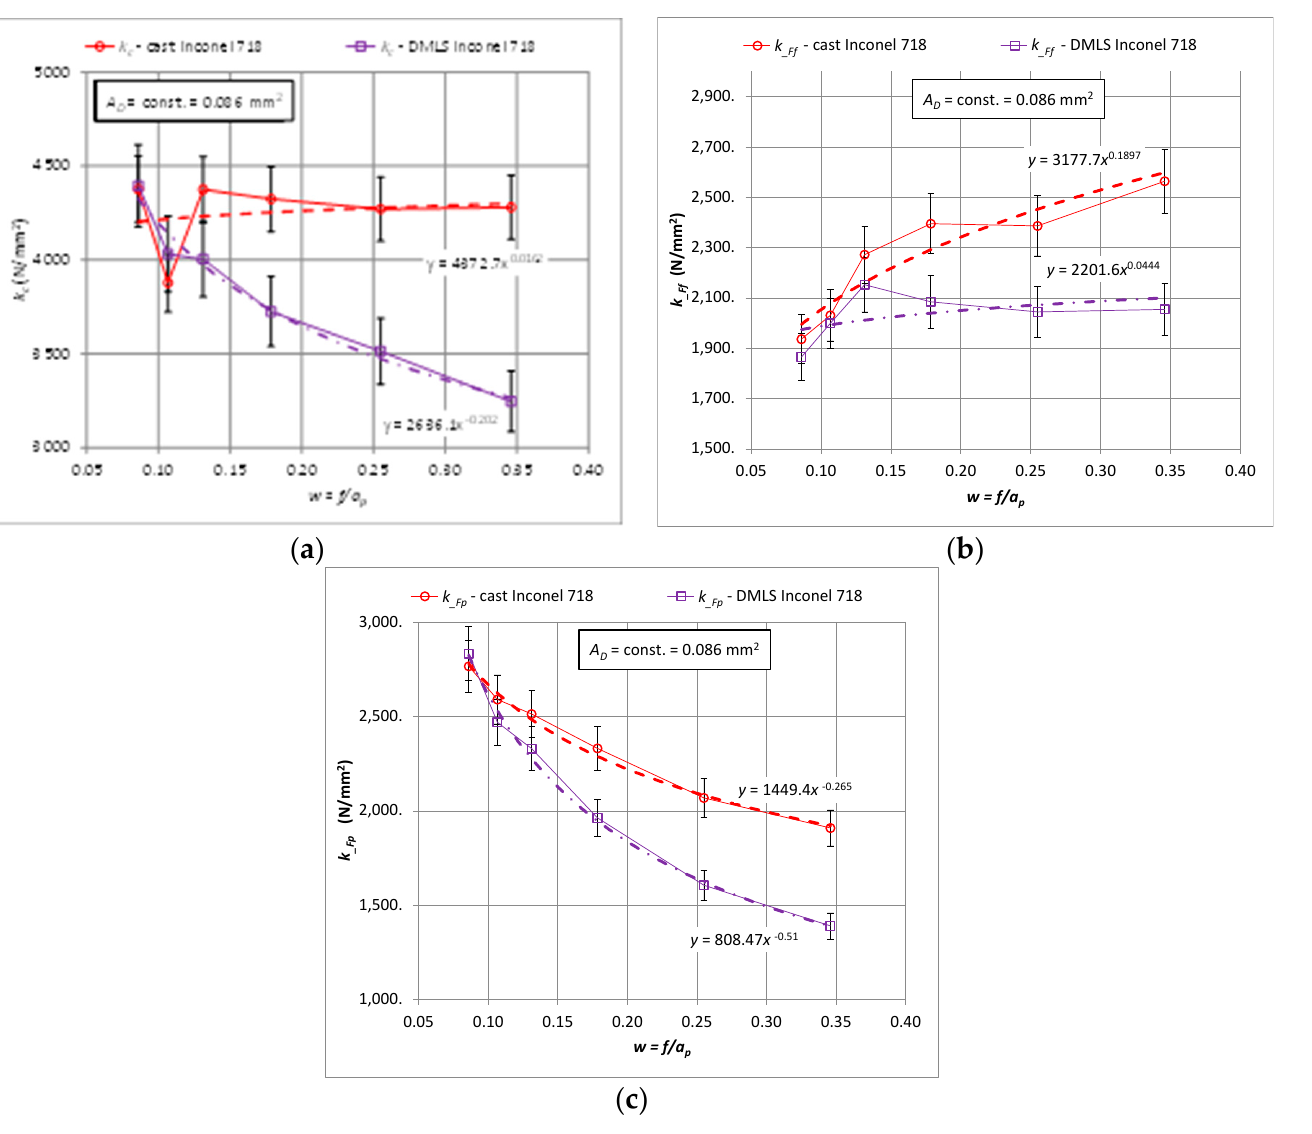
Figure 4. Relationship of specific cutting force for the components F c , F f , F p for turning with a constant cross-section of the cutting layer A D = 0.8 mm 2 for the printed and cast Inconel 718 alloy, ( a ) k c , ( b ) k _Ff , ( c ) k _Fp .